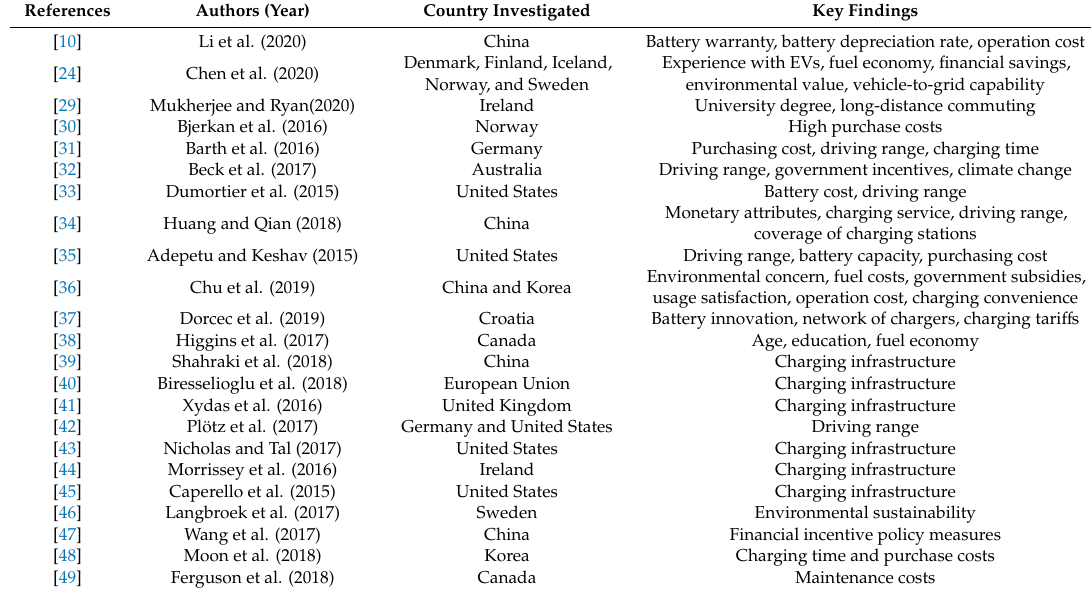
Table 1. Recent researches on factors influencing consumers electric vehicle (EV)